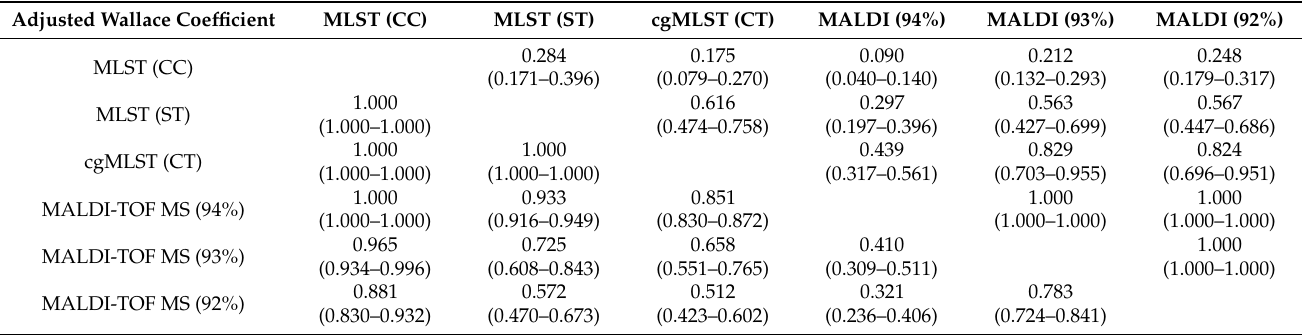
Table 2. Adjusted Wallace coefficient (CI 95%) for typing schemes